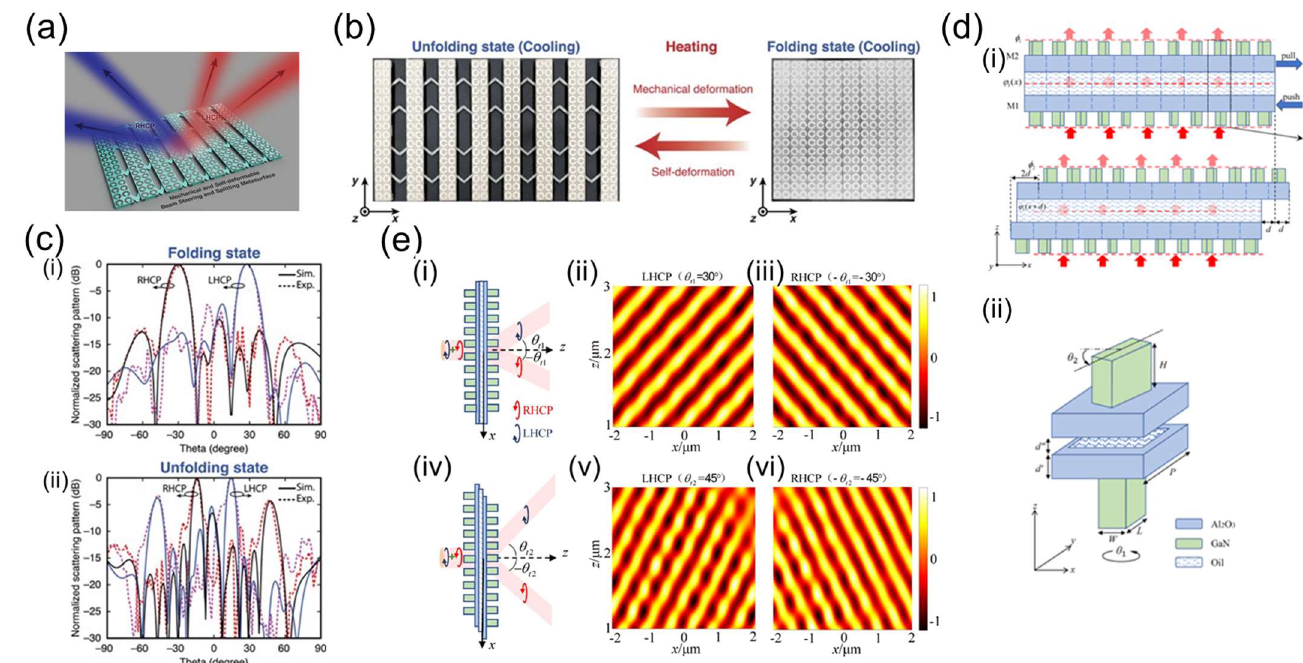
Figure 17. ( a ) Conceptual diagram of mechanical and self−deforming spatially modulated metasurfaces [140]. Copyright 2021 John Wiley and Sons. ( b ) Photographs of the metasurface in unfolded and folded states [140]. Copyright 2021 John Wiley and Sons. ( c ) Numerical simulation and measurement results of LCP and RCP output waves in folded ( i ) and unfolded ( ii ) states [140]. Copyright 2021 John Wiley and Sons. ( d ) Side view of the bilayer geometric metasurface ( i ), and a 3D repre- sentation of the unit cell ( ii ) [141]. ( e ) Simulated electric field distribution of split LCP and RCP lights before ( i − iii ) and after ( iv − vi ) lateral displacement [141]. Table 8. Parameters of mechanical systems control tunable metasurface beam splitters described in this section.